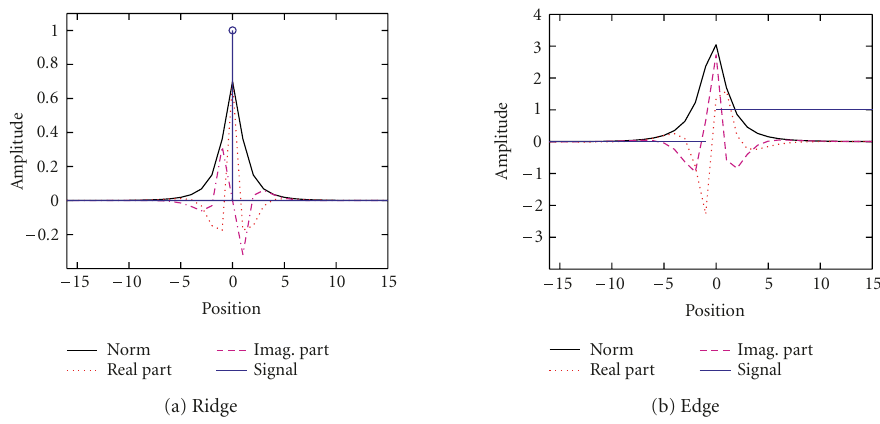
Figure 4: Log-Gabor wavelet response to edges and ridges. (a) Response of a 1D complex log-Gabor filter to an impulse (ridge): the modulus (black continuous curve) of the response monotonously decreases away from the impulse. It implies that the ridge is situated just on the local maximum of the response. On the contrary the real (dot) and imaginary (dash-dot) parts present various local-maxima and minima which makes them less suitable for ridge localization. (b) Same curves for a step